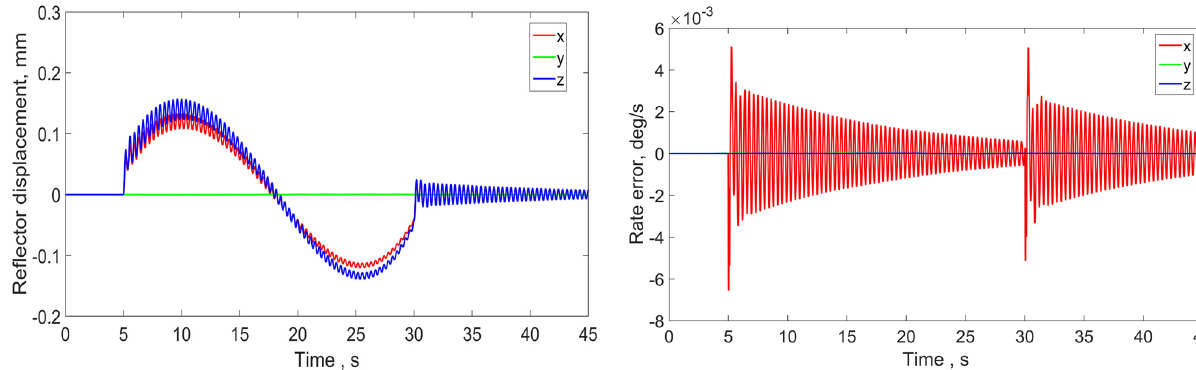
Figure 29: Re fl ector displacements for case 3 ( w = 0.3 ) .